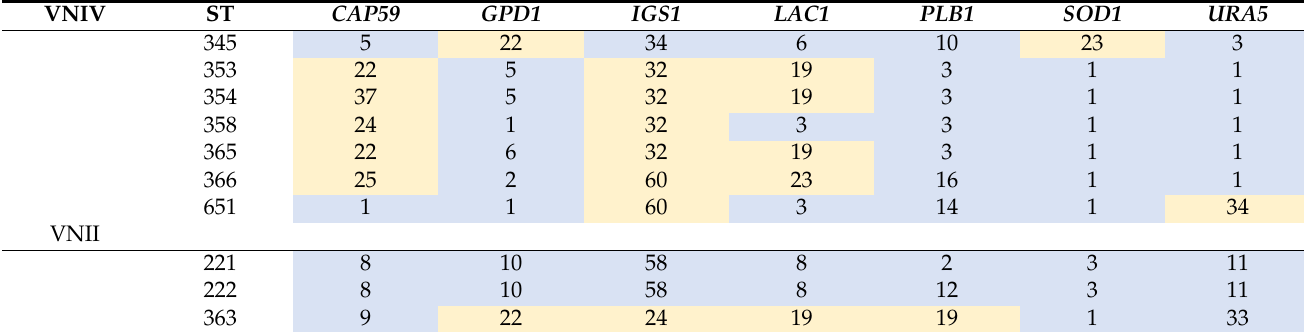
The first column represents the original molecular type assignment found in the ISHAM MLST database. Alleles highlighted in blue represent those in the serotype A cluster, while those highlighted in yellow represent alleles in the serotype D cluster.